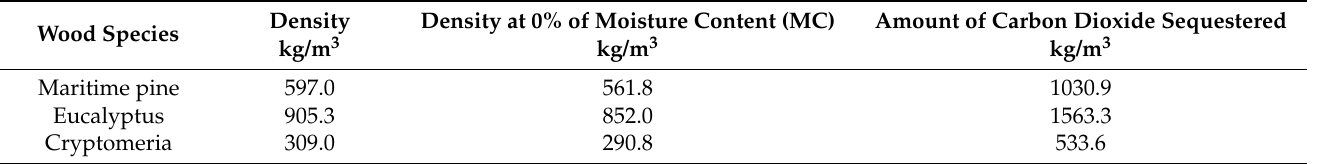
Table 5. Calculation of carbon content of each